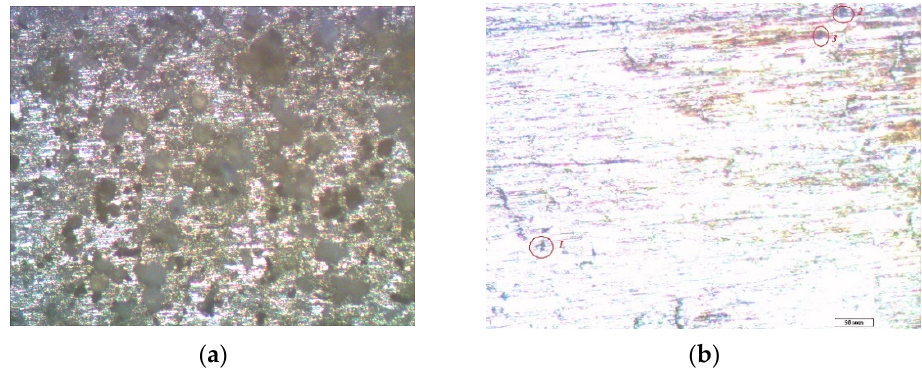
Figure 9. Micrographs of the surface area of a zinc sample pre-modified with a solution containing a mixture of [1% VS + 1% AS] after conducting full-scale, one-year natural tests in an urban atmosphere: ( a ) immediately after the tests but before the removal of the corrosion products; and ( b ) after the removal of the corrosion products. Optical magnification of 10 × , with defects highlighted in red.